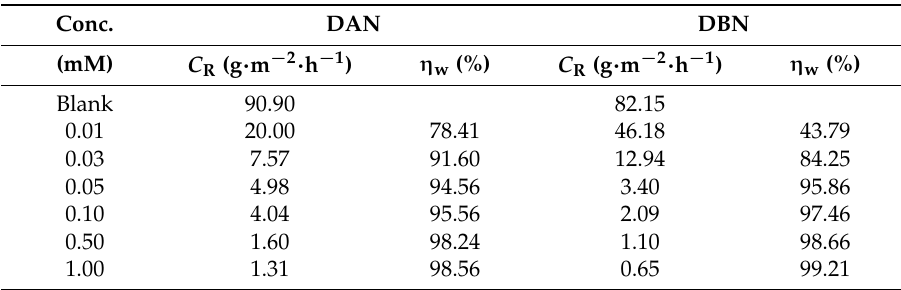
Table 1. Corrosion parameters for aluminum alloy in a 1 M HCl solution with inhibitors concentrations range from 0.01 mM to 1.00 mM at 30 °C.